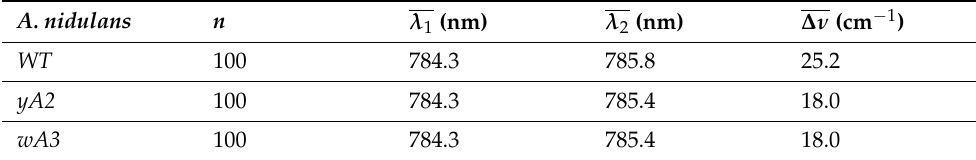
Table 2. Sample and laser parameters for A. nidulans strains [71,75].